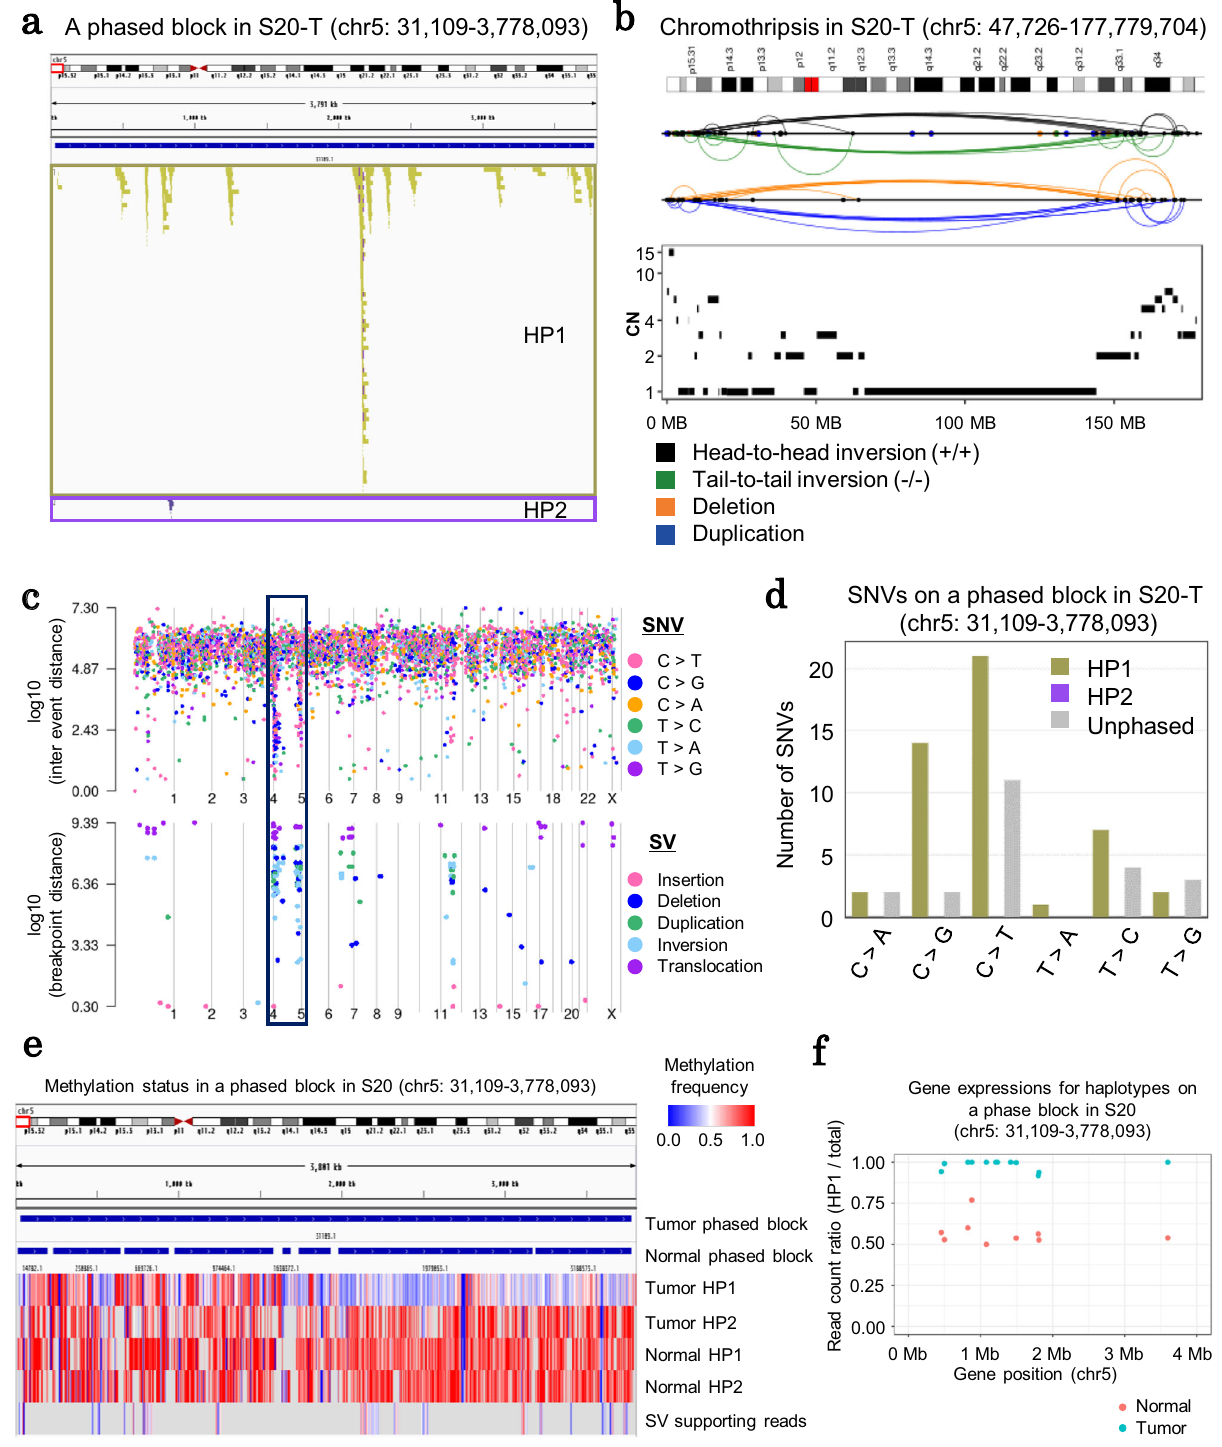
Fig. 6 Chromothripsis on a haplotype level. a An example of a phased block (chr5: 31,109 – 3,778,093) on which SVs have been found concentrated in case S20. Each color represents the haplotype of the reads supporting SVs. b An example of chromothripsis events in chromosome 5 as identi fi ed in case S20. The cluster of interleaved SVs is presented in the upper panel, whereas the CN patterns are presented in the lower panel. c Genome-wide information on the SNV and SV density of case S20. In the upper panel, the mutational patterns of the SNVs are represented in different colors and the potential kataegis is highlighted with arrows. Breakpoints for the SVs are shown for each respective color in the lower panel. d The number of SNVs corresponding to each haplotype in the phased block (chr5: 31,109 – 3,778,093). e Methylation status at the phase block located within the chromothripsis region of case S20. Normal and tumor panels demonstrate methylation frequencies calculated with reads assigned to each haplotype. The SV panel presents the frequencies calculated with SV-supporting reads detected by Nanomonsv. f Gene expressions for haplotypes at the phase block (chr5: 31,109 – 3,778,093) of case S20. Read ratios of HP1 and HP2 in normal and tumor tissues are shown with separate colors. Source data are provided as a Source Data fi le for d